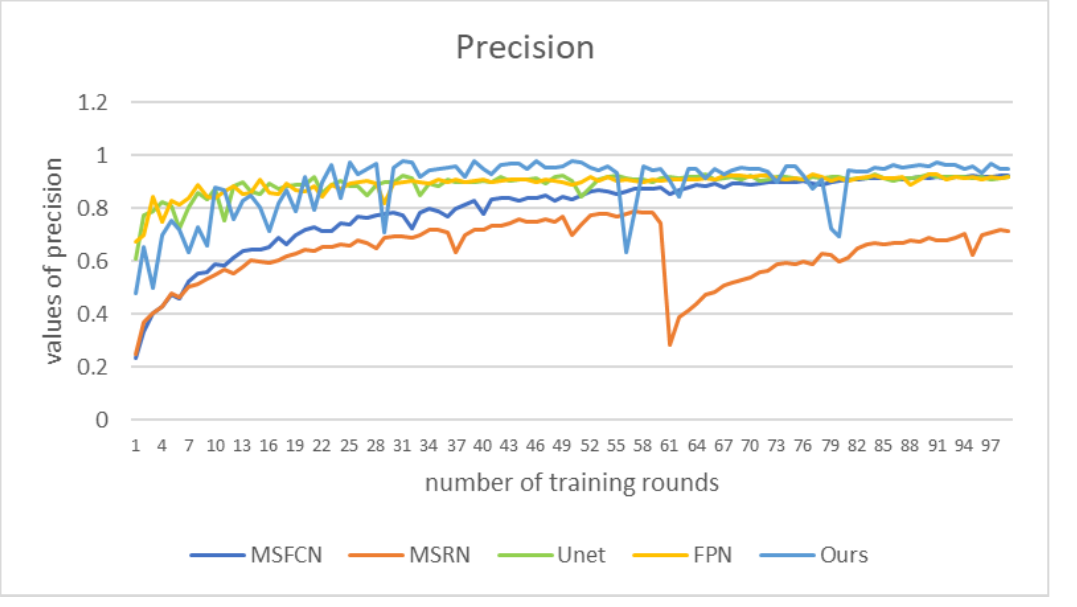
Figure 14. Precision values of different models under corresponding epochs.